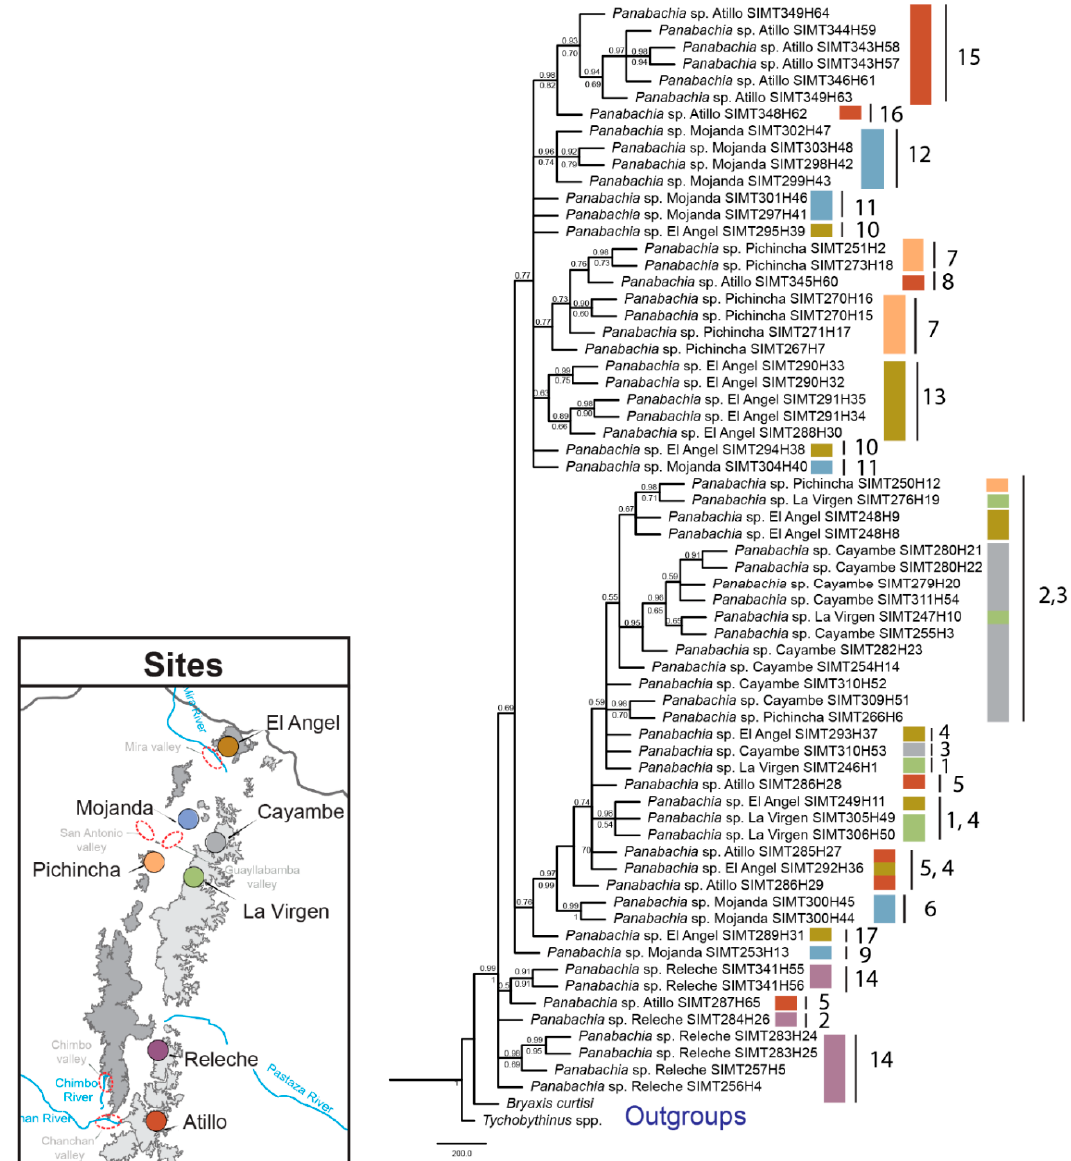
Figure 6. Posterior probability tree for the nuclear protein-coding gene wingless of Panabachia . Branch lengths are in proportion to the number of substitutions per site, in reference to the scale bar. Posterior probabilities are shown above the branches and bootstrap support values for the ML tree are shown below branches.